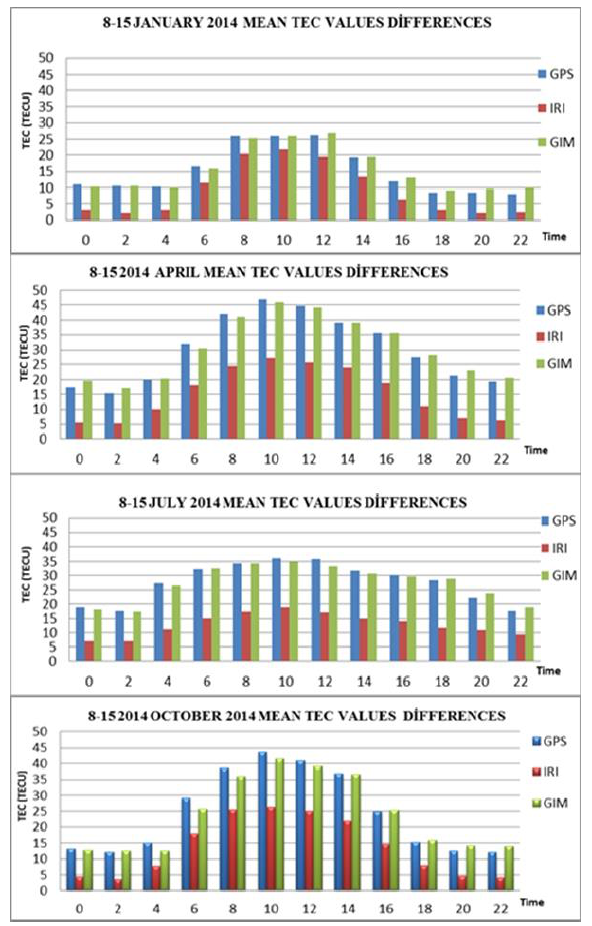
Figure 3. 8-15 January, April, July, October 2014 TEC Values Differences